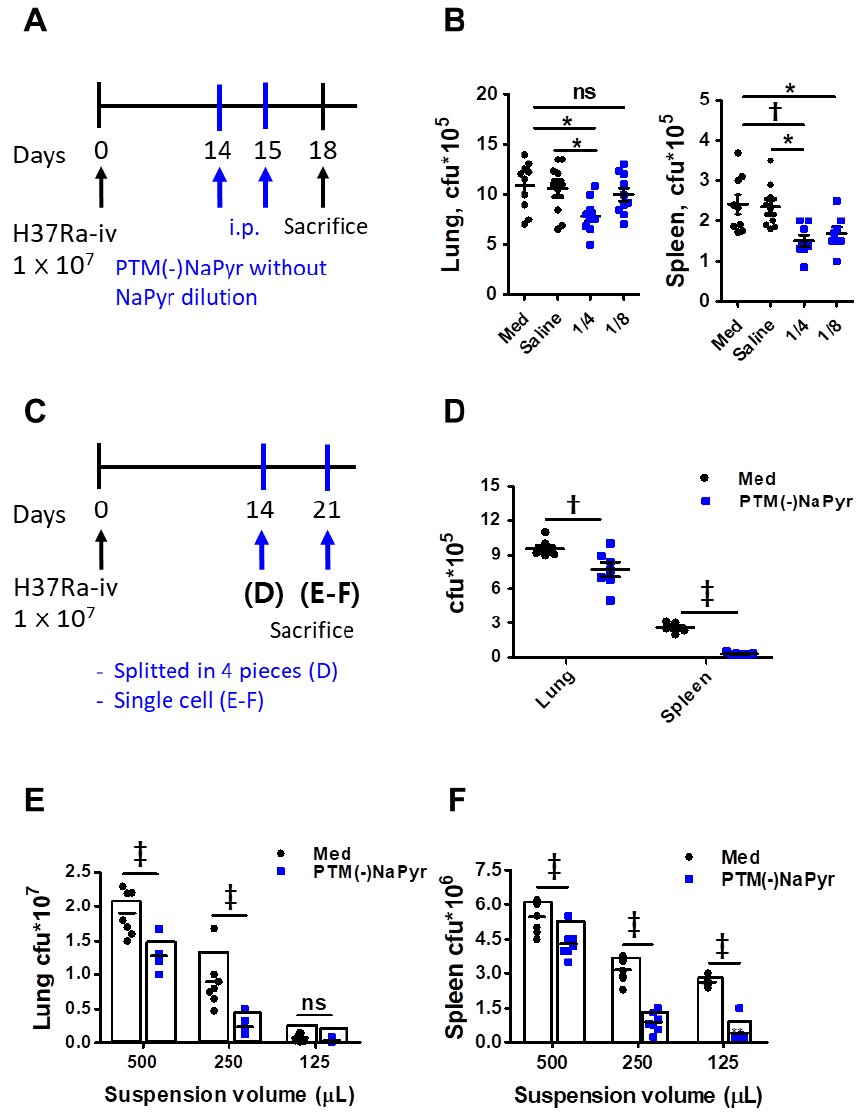
Figure 9. Intraperitoneal injection and direct contact with PTM reduce intracellular bacterial growth in Mtb H37Ra-infected mice. ( A ) Experimental schedule of PTM injected i.p. into mice in vivo. ( B ) Numbers of intracellular bacterial colony-forming units (CFUs) in lung and spleen tissues. ( C ) Ex- perimental schedule of direct PTM exposure of excised spleens and lungs. ( D ) Spleen and lung tis- sues were cut into four sections each and incubated in 4-fold-diluted PTM without NaPyr for 1 h, then bacterial CFUs were counted. ( E ) Lungs and ( F ) spleens from Mtb H37Ra-infected mice were homogenized and divided into groups incubated with untreated media and 4-fold-diluted PTM without NaPyr for 1 h. All data are presented as means ± SEM of at least three independent experi- ments (n = 5 – 8 mice per group; * p < 0.05, † p < 0.01, and ‡ p < 0.001; ns: not significant vs. untreated mice). 4. Discussion The H 2 O 2 and ONOO - generated by NTPJ or PTM are of great interest to plasma med- icine researchers because these cause the selective induction of cancer inhibition factors [15,19]. However, to our knowledge, selective toxicity studies on the effects of direct and